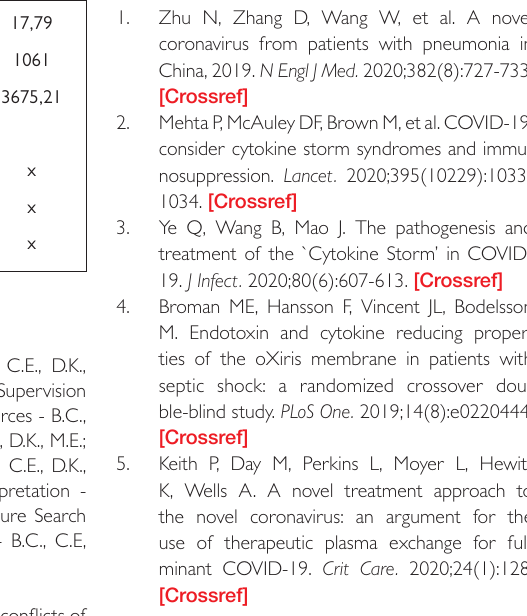
Table 1. The Laboratory Levels of the Patients. The Yellow Areas of the Tables Are the Application Period of CPFA PATİENT